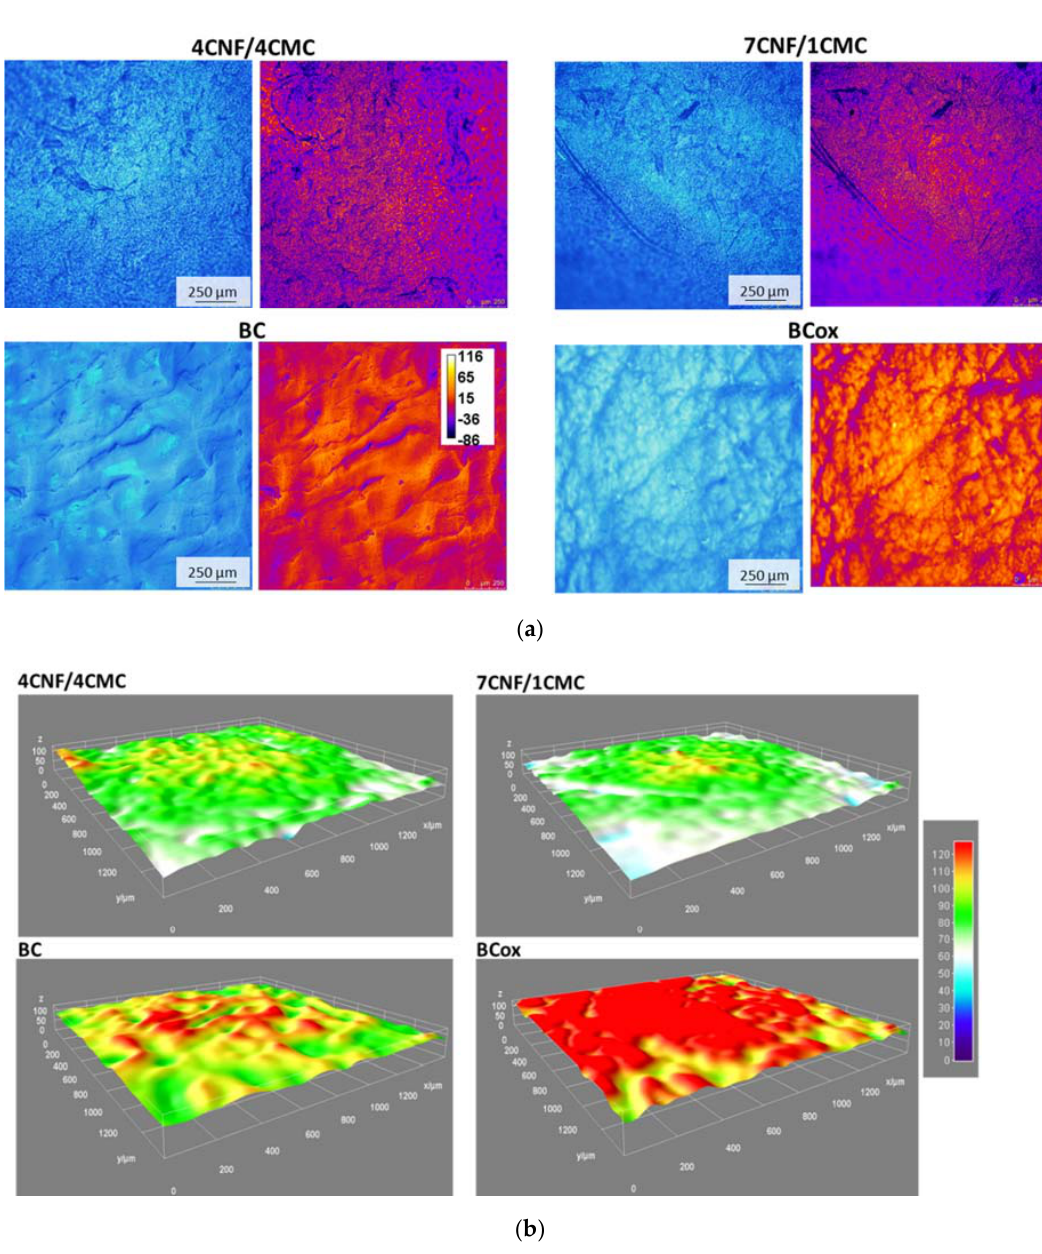
Figure 5. ( a ) CFM micrographs of cellulose membranes, designated as 4CNF / 4CMC, 7CNF / 1CMC, BC, and BCox, depicted in a fully swollen state with respective color-coded surface images from the fluorescent channel. The calibration bar (in µ m) corresponds to di ff erent distances from the optical plane in focus. ( b ) 3D thermal surface plots with the calibration bar (in µ m) on the right corresponding to di ff erent roughness levels.